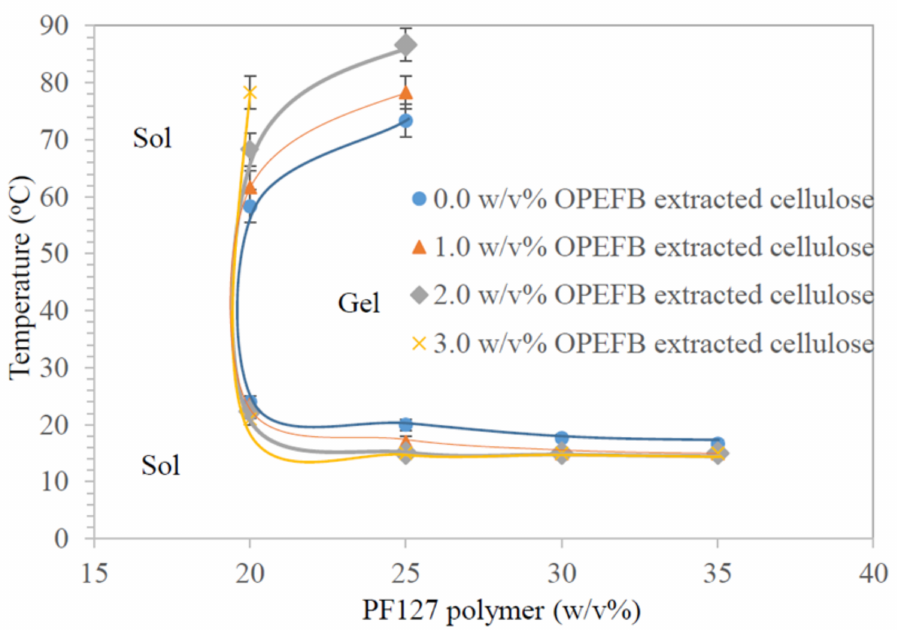
Figure 1. Phase diagram of the thermo-responsive cellulose